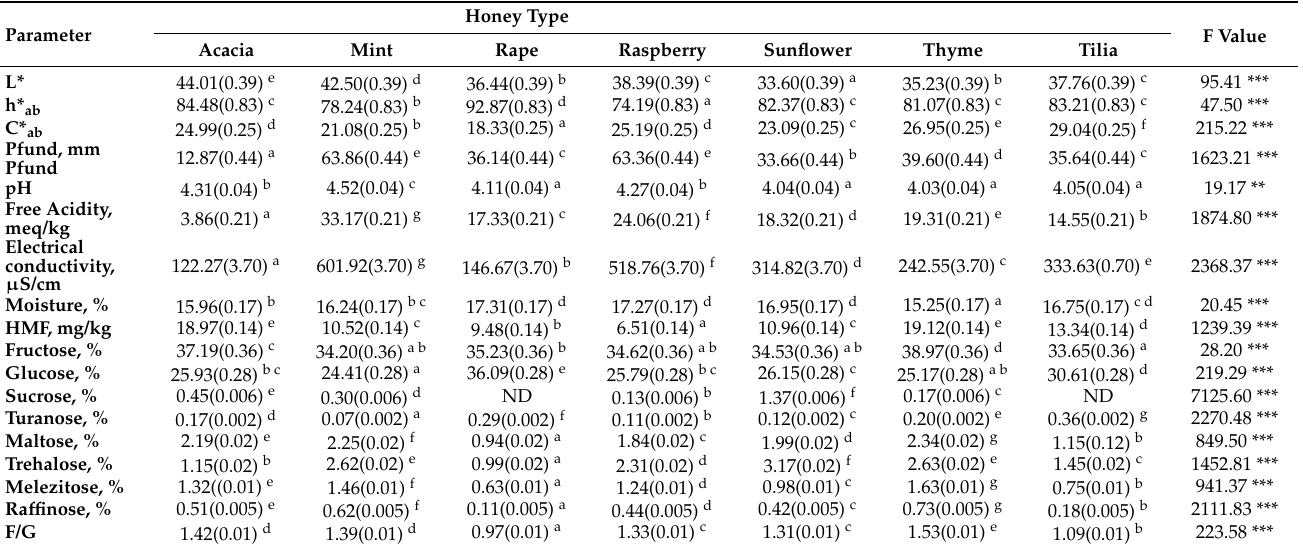
Table 1. Physicochemical parameters of seven types of honey (acacia, mint, raspberry, rape, sunflower, thyme and